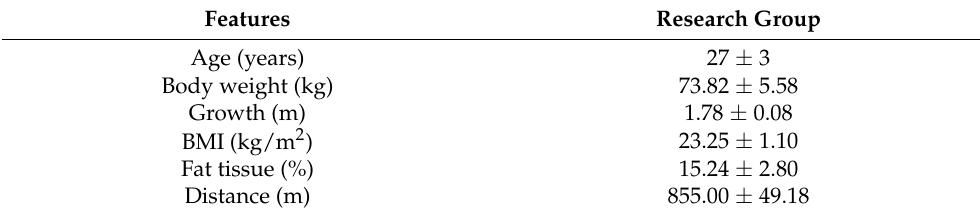
Table 1. Features of the research group.